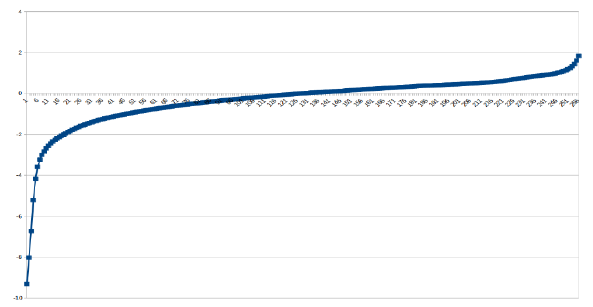
Figure 4. Camera response function.